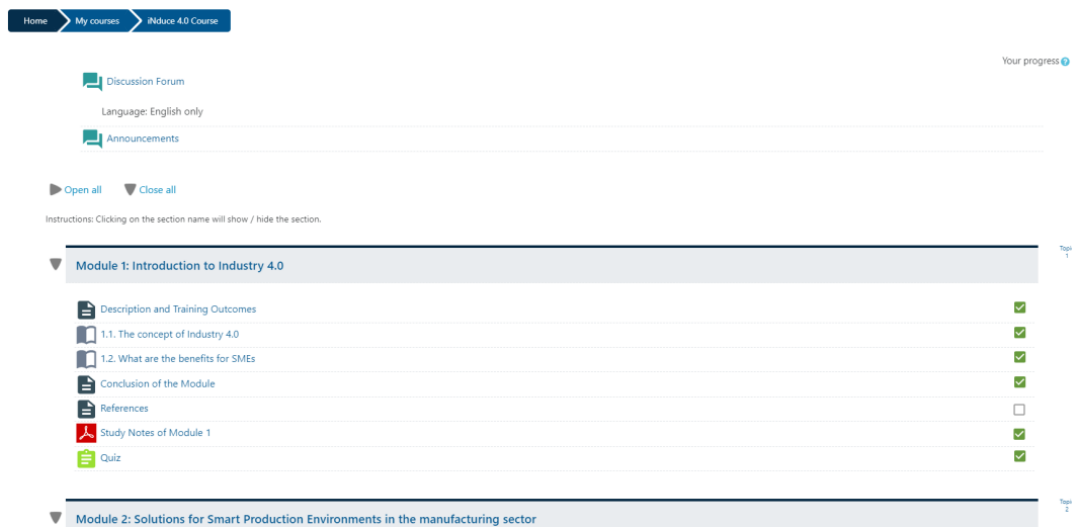
Figure 2. Structure of training modules.